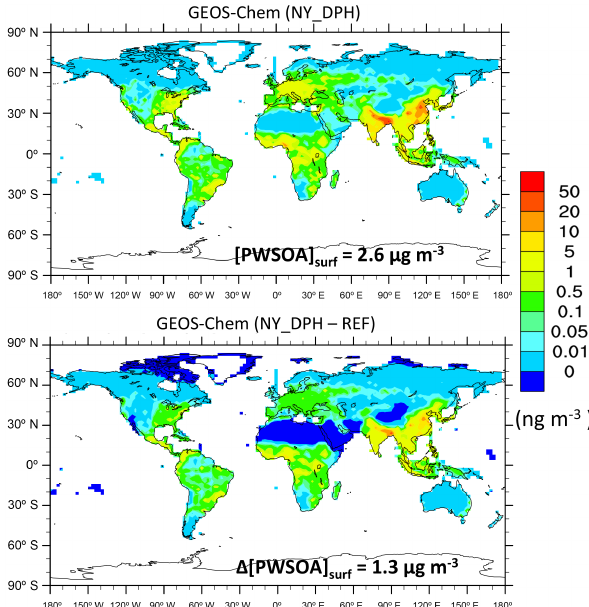
Figure 10. Contribution of individual models grid cells to global population-weighted surface SOA concentration [PWSOA] surf in the NY_DPH simulation (top) and to changes in [PWSOA] surf be- tween the NY_DPH and REF simulation. The total PWSOA is ob- tained by summing up the individual grid cell contributions shown in the